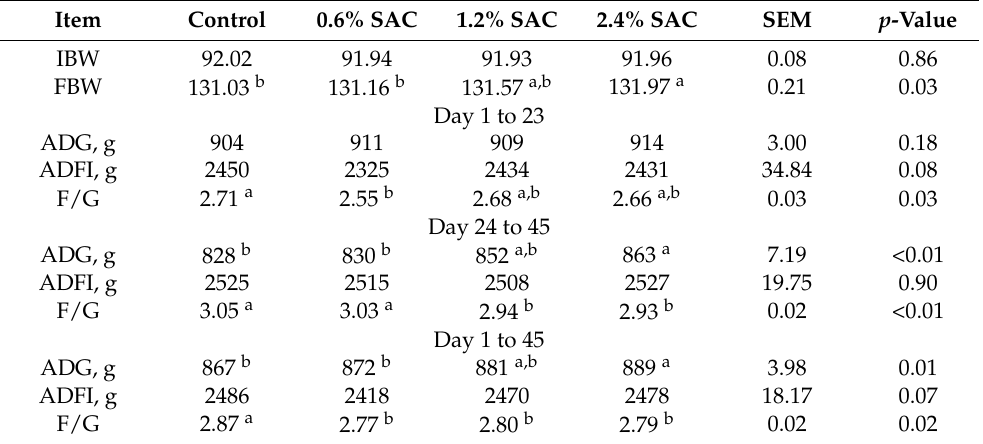
Table 6. Effects of dietary Selenium Auricularia cornea culture supplementation on growth perfor- mance of growing-finishing pigs (Exp.